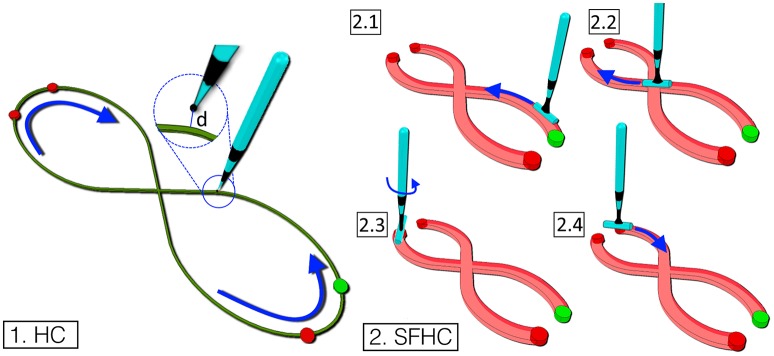
The figure represents the two trajectories designed. Task 1. A line following task shaped as an half cloverleaf (HC). The aim to to finely follow the trajectory starting from the green dot and moving anti-clockwise. Task 2. In the task, shaped as a thicker half cloverleaf (SFHC), the users have to orient the tool's cylindrical end-effector along the trajectory (2.1–2.4).